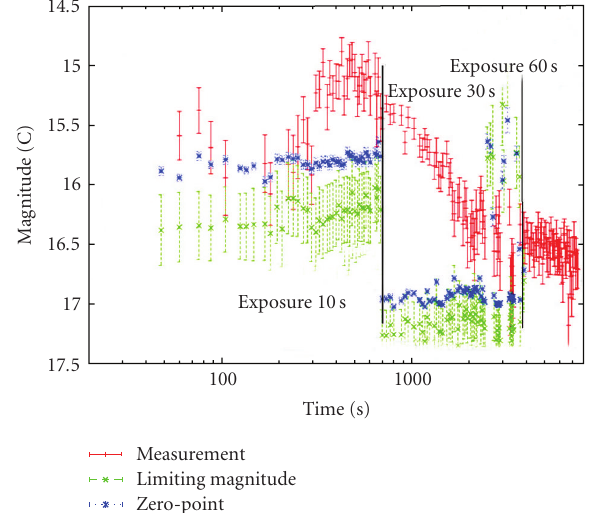
Figure 5: The Watcher light curve of the prompt and early afterglow emission from GRB 080905B in the clear filter band with the time quoted relative to the GRB trigger time. The zero-point and limiting magnitude for every exposure are also shown. Since the value of the zero-point is related to the total number of counts per exposure time unit, its temporal evolution is correlated with the limiting magnitude evolution and the exposure